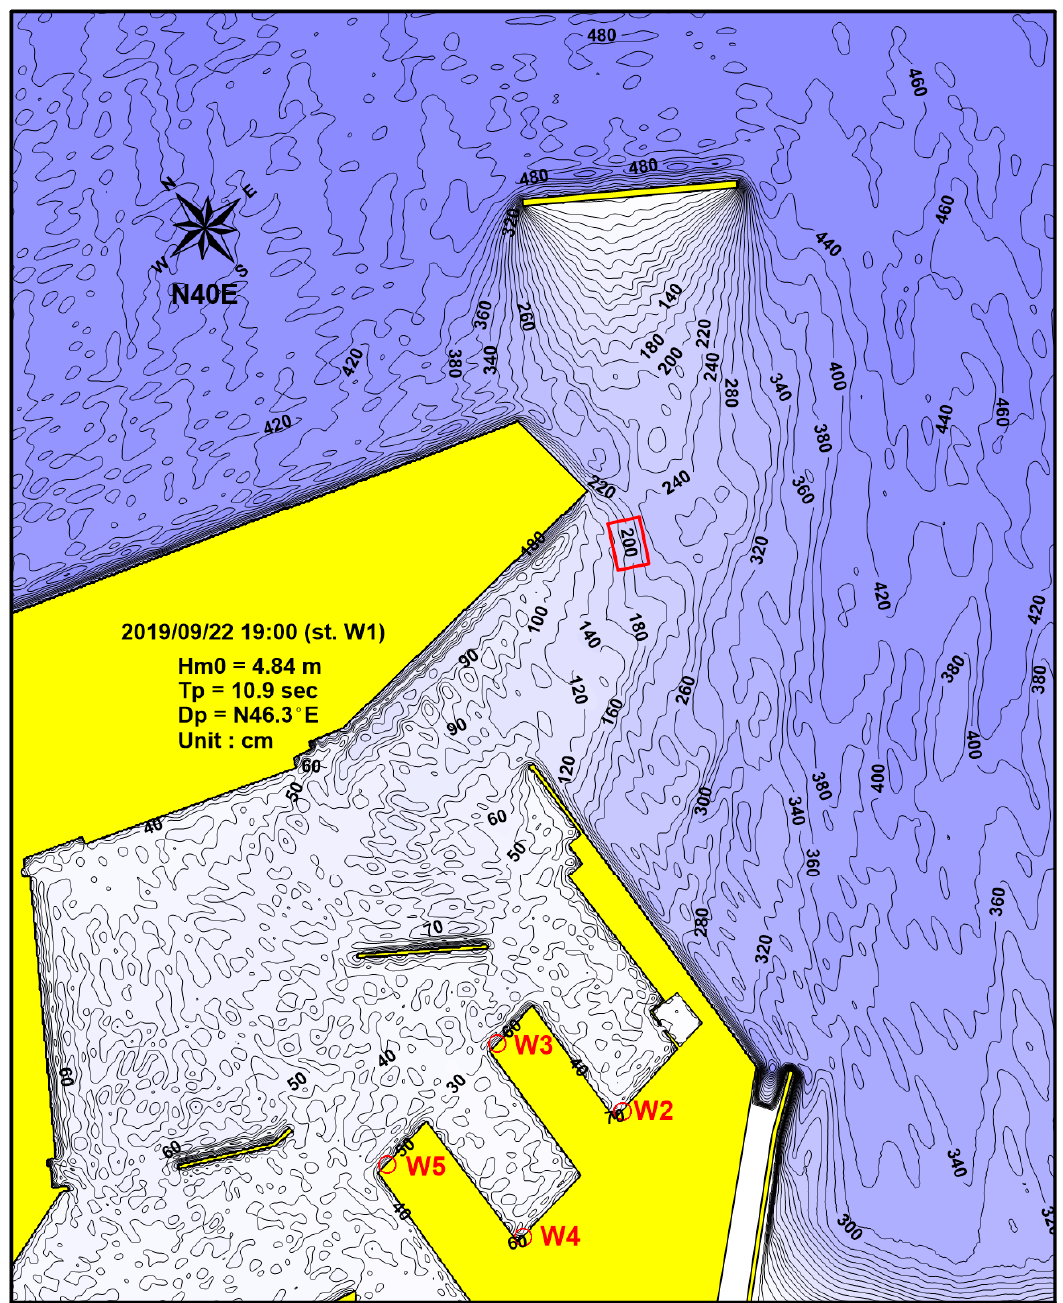
Figure 17. Contours of wave height isolines at 19:00 on 22 September 2019 when H m 0 became maximum during the 39 h of the simulation time shown in Figure 16, in the case of AC. The input H m 0 was 4.84 m at the open boundary, which was reduced to 2.0 m (59% reduction) near the entrance of Pohang New Port (marked in a red rectangle). It is also noted that the location of the 2.0 m H m 0 isoline was slightly outside the port entrance compared to that in BC (Figure